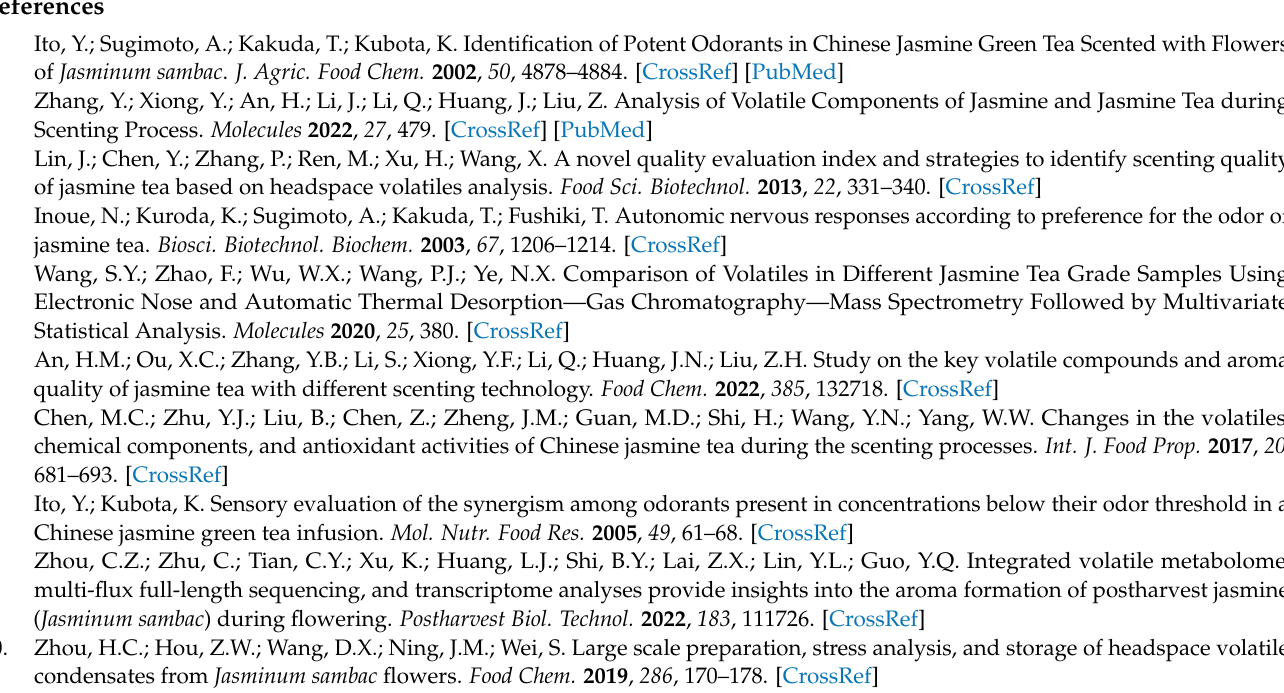
tea samples; Figure S7: OPLS-DA score plots (left), permutation tests (middle), and S-plots of each pairwise comparison between the jasmine tea samples with different rounds of scenting processes; Figure S8: Number of differential metabolites of each pairwise comparison of jasmine tea during consecutive scenting; Table S1: Volatile profiles of base tea and jasmine teas with different rounds of scenting processes; Table S2: The content of differential VOCs in subclass 1; Table S3: The content